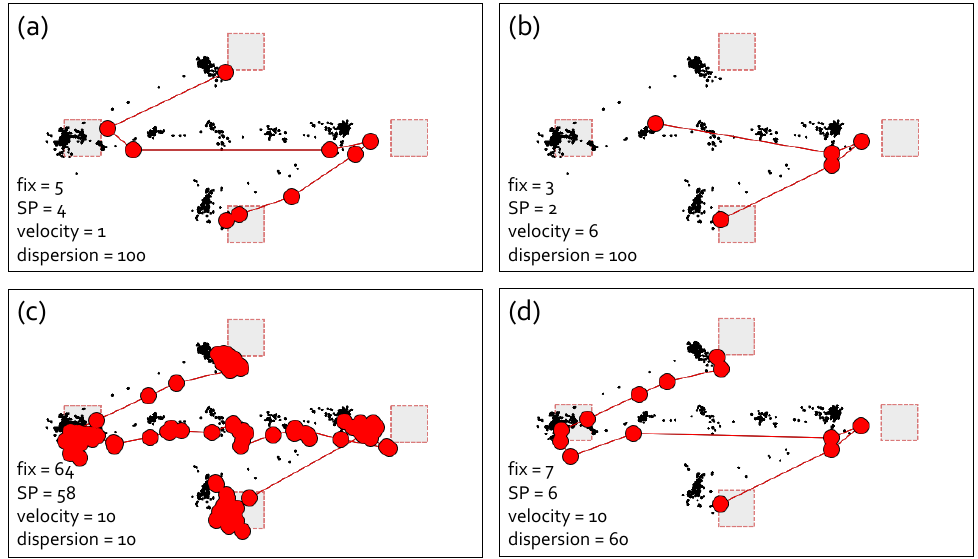
Figure 6. I-VDT smooth pursuit identification. ( a – d ) The different cases of eye movement event identifications. The velocity and dispersion threshold parameters in each case are presented in each image. The black dots denote the raw gaze points, and the red dots indicate the fixations and smooth pursuits. The red links are the